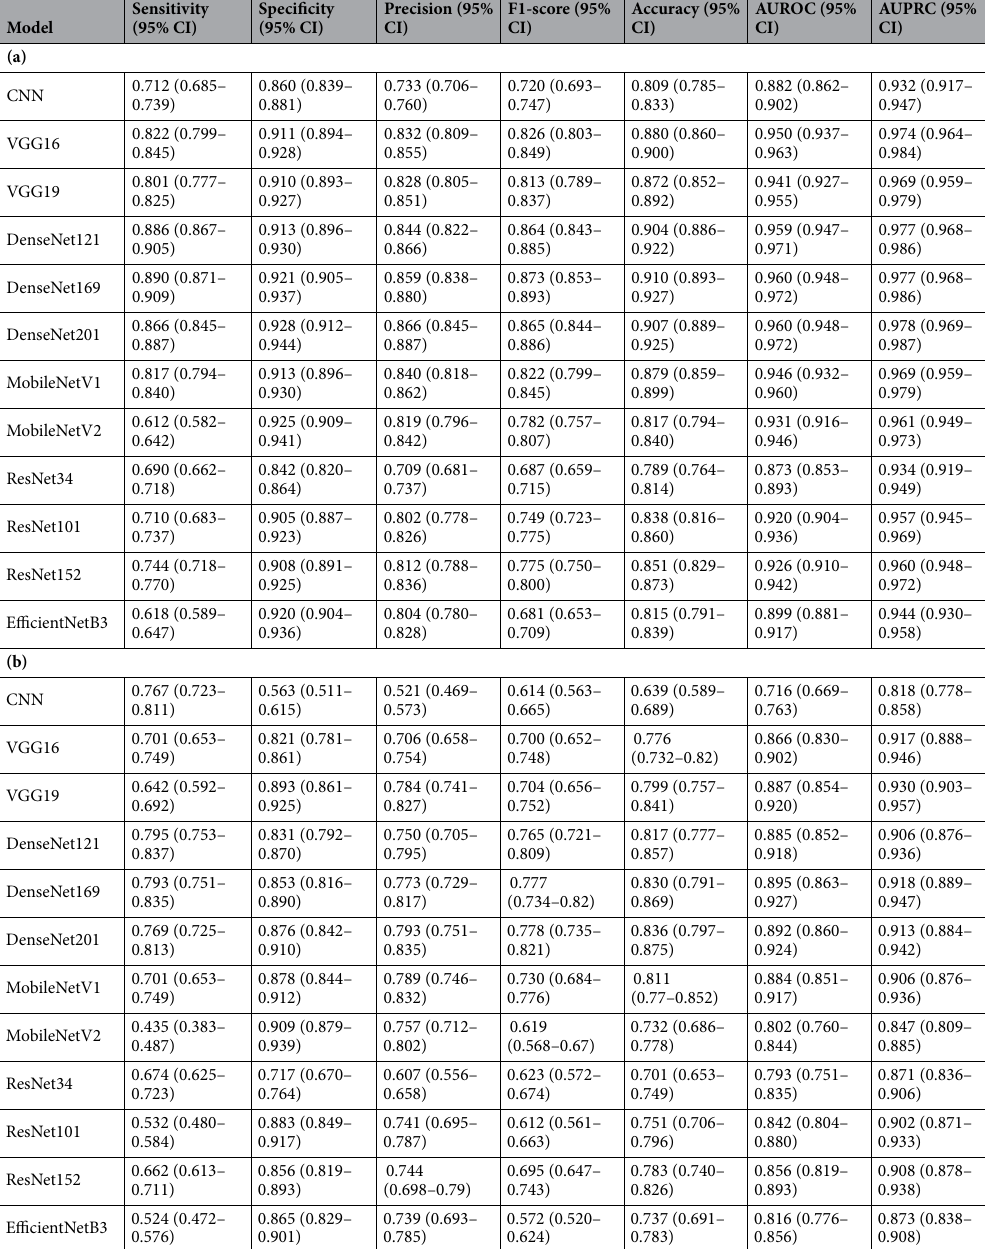
Table 2. Diagnostic performance of CNN models in internal validation (a) and external validation